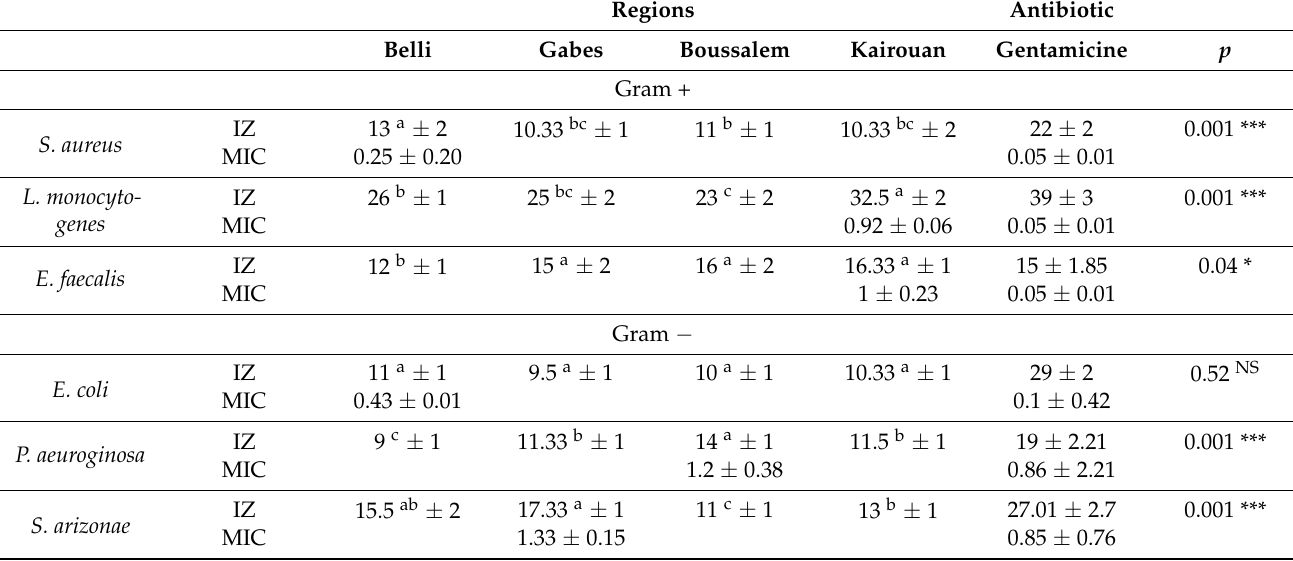
Table 5. In vitro antimicrobial activities of methanolic lemon verbena extracts collected in four